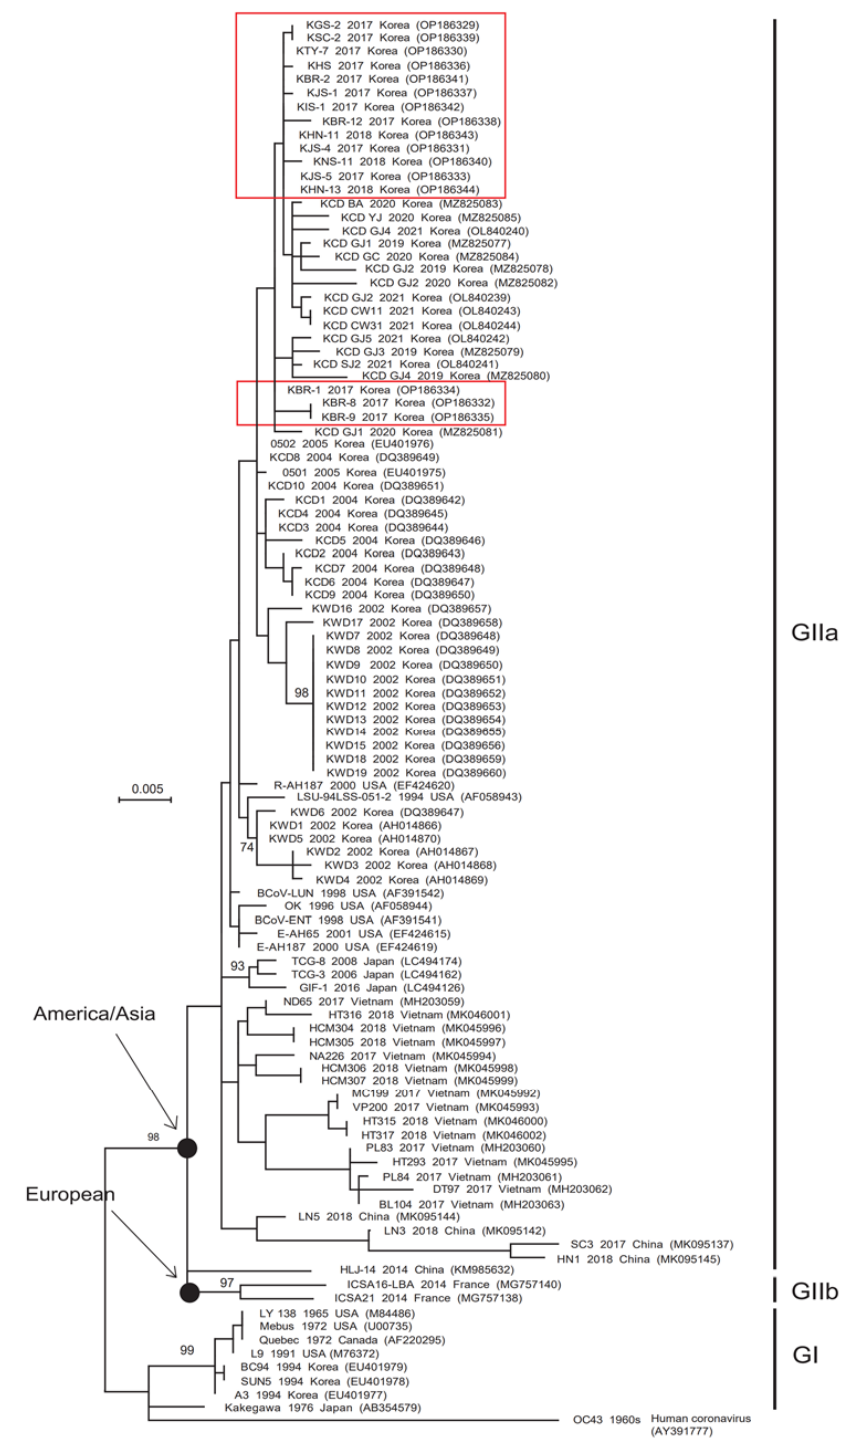
Figure 2. Phylogenetic tree based on the complete HE gene sequences of BCoV reference strains isolated worldwide, including the 2017–2018 strains detected in this study. The phylogenetic (LogL = − 3940.11) tree was constructed using the maximum ‐ likelihood method (Tamura ‐ Nei model), with bootstrap values (1000 replicates) ≥ 70%, in MEGA 7.0 software. The sequences identified in this study are marked by a red box.